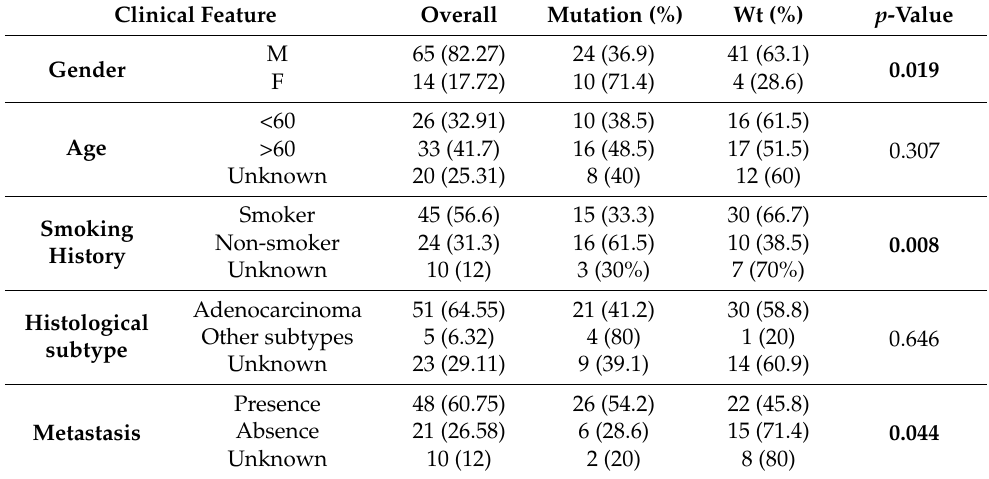
Table 3. EGFR mutations and clinicopathological feature of Tunisian